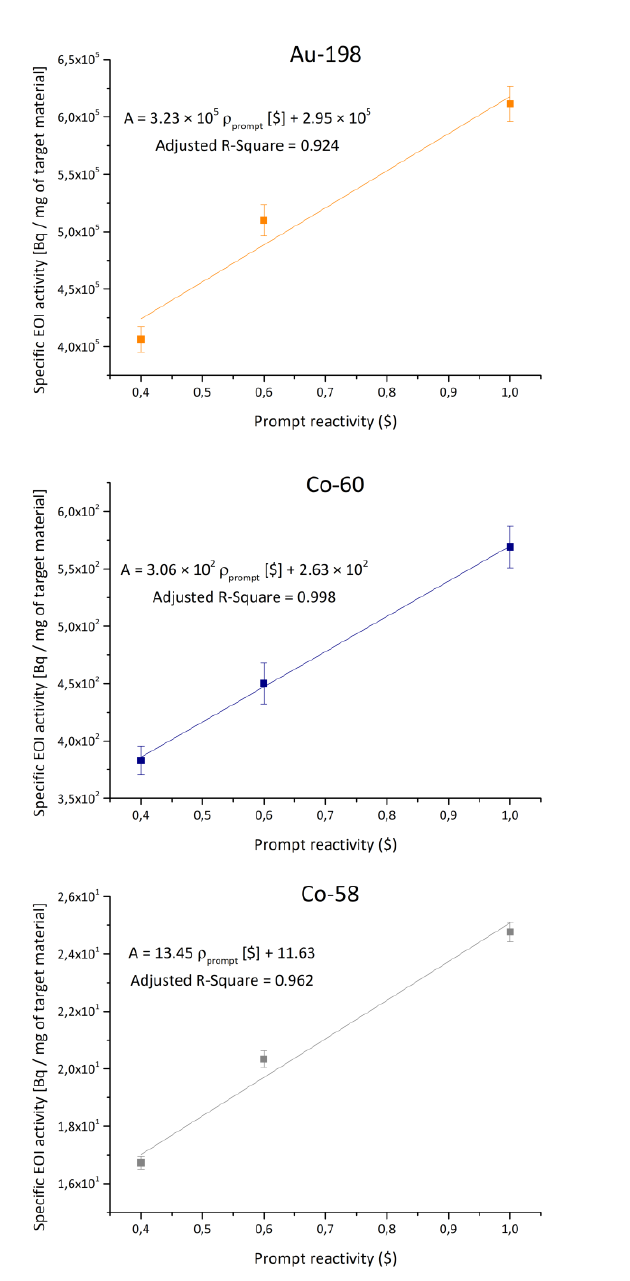
Fig. 7. Measured specific end-of-irradiation activities [Bq per mg of target material] for Au-198, Co-60 and Co-58, originating from the Au-197(n,γ), Co- 60(n,γ) and Ni-58(n,p) reactions, as a function of the prompt reactivity. A linear dependence is expected. Cherenkov light radiator. The inner surface of the channel was smooth, which enabled the Cherenkov light produced in the water to be reflected and to be visible at the reactor platform level Fig. 8 a photograph of the setup on the JSI TRIGA reactor platform and Fig. 9 shows a photograph of the Cherenkov light inside the channel during reactor